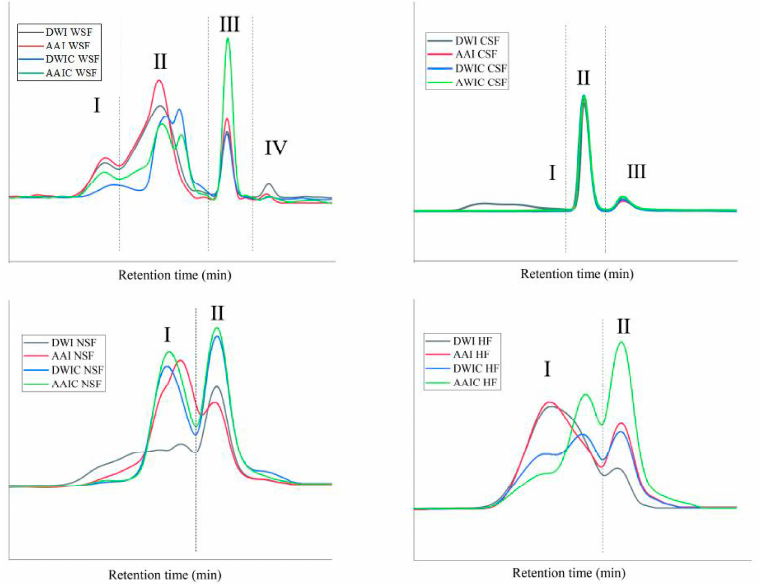
Figure 5. Variations in molecular weight distribution of cell wall fractions between different treatment groups. According to the number of peaks in DWI, we divided the peaks into different regions, which are represented by I, II, III and IV, respectively. DWI: distilled water immersion for 15 h; AAI: 0.6% acetic acid immersion for 15 h; DWIC: cooked DWI; AAIC: cooked AAI; WSF: water-soluble fraction; CSF: chelate-soluble fraction; NSF: sodium carbonate-soluble fraction; HF: hemicellulose